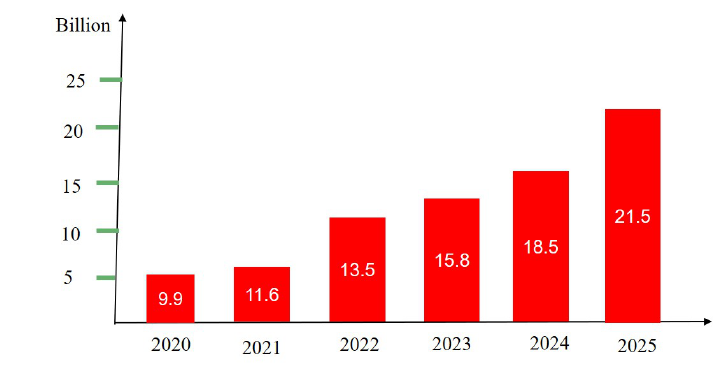
Figure 1. The active devices’ number connections worldwide